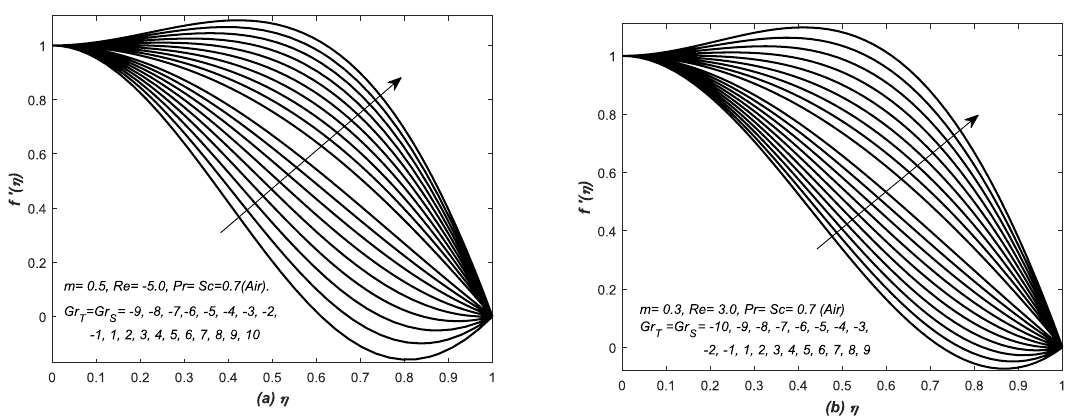
Figure 7. The dimensionless velocity f ′ (η) is plotted against the similarity variable η for assisting and opposing flow of air inside ( a ) converging and ( b ) diverging channels.